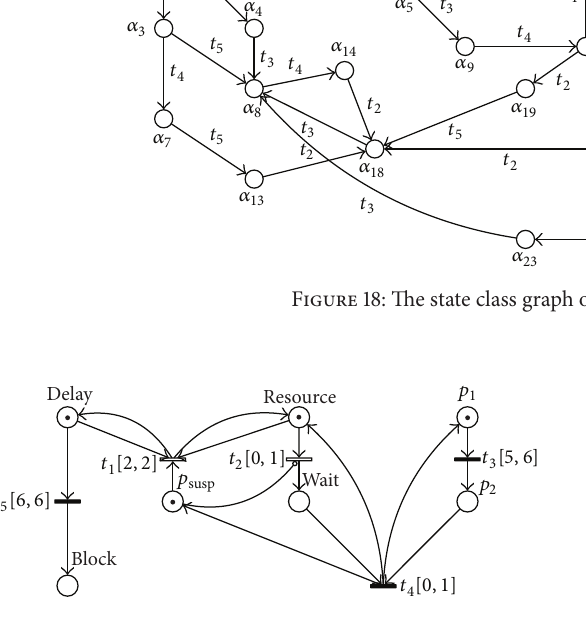
Figure 19: Controlled model of Figure 17 using inhibitor